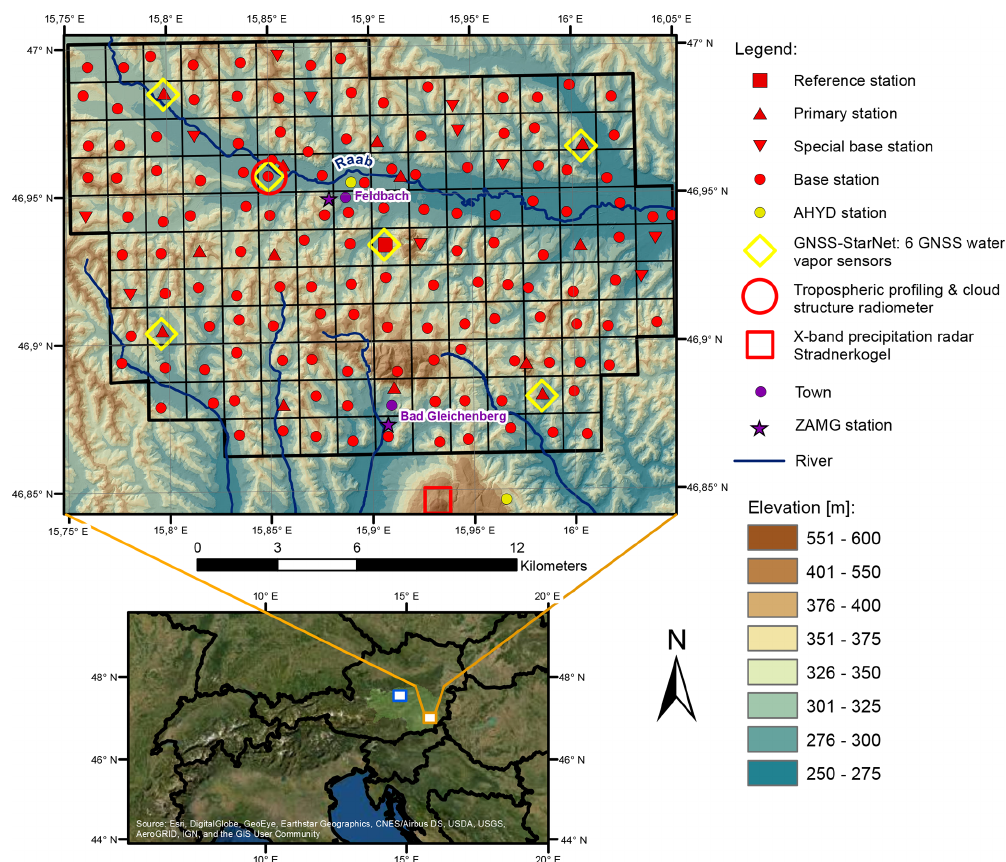
Figure 6. The WegenerNet Feldbach Region (FBR) 3D Open-Air Laboratory for Climate Change Research, consisting of the ground station network as described in this paper and additional 3D-observing-system components including an X-band precipitation radar; a tropospheric profiling and cloud structure radiometer pair; and a GNSS station network called GNSS-StarNet, comprising six GNSS receivers for water vapor sensing. The legend on the right explains all map